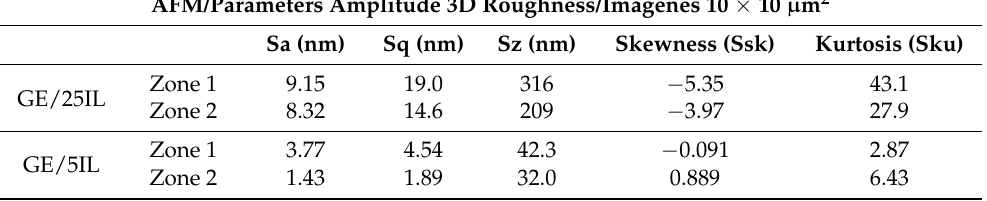
Table 9. Roughness parameters were calculated from the 10 × 10 µ m 2 field of view images obtained by AFM of zone 1 and 2 of GE/5IL and GE/25IL.